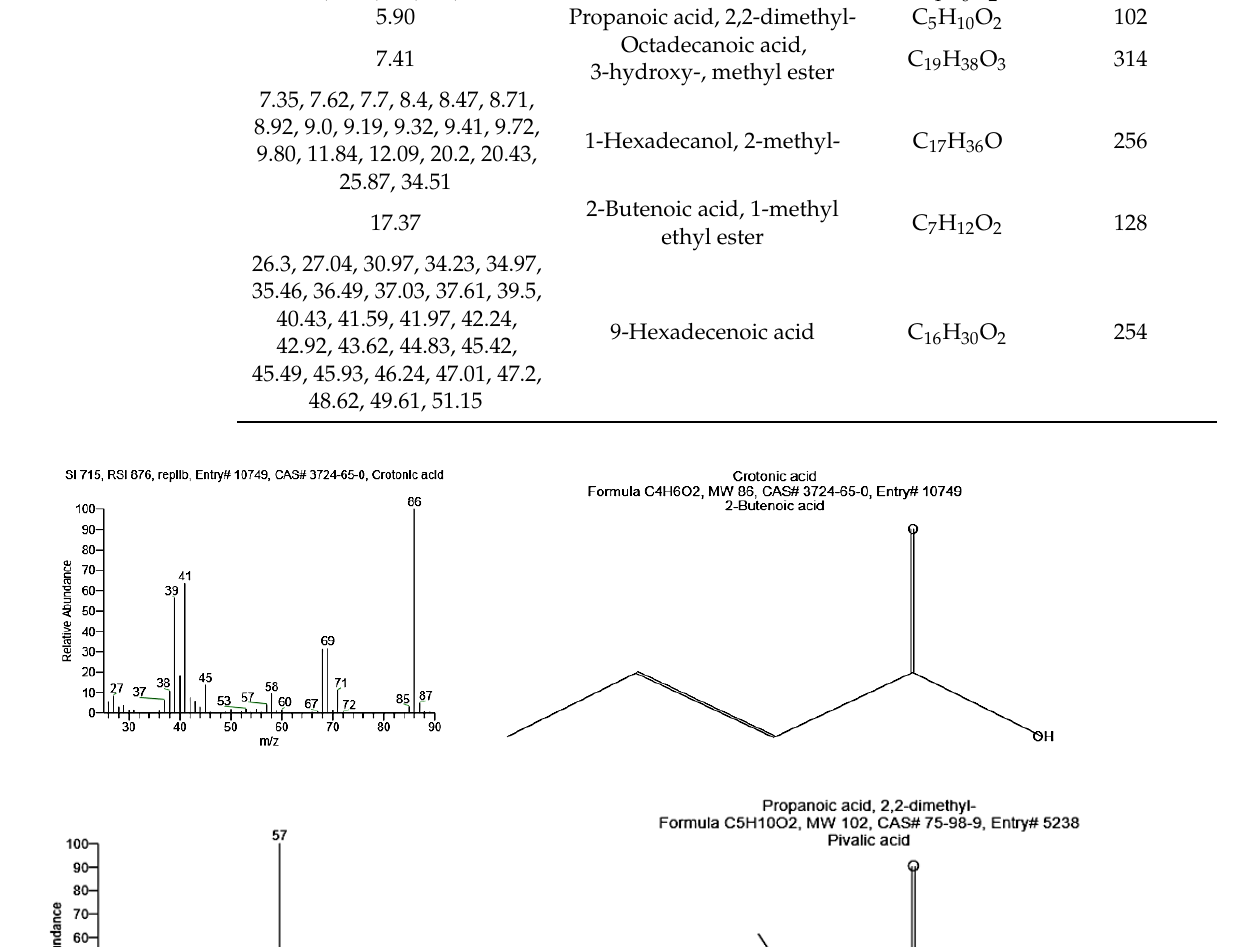
Table 3. GC-MS data table for polyhydroxybutyrate (PHB).